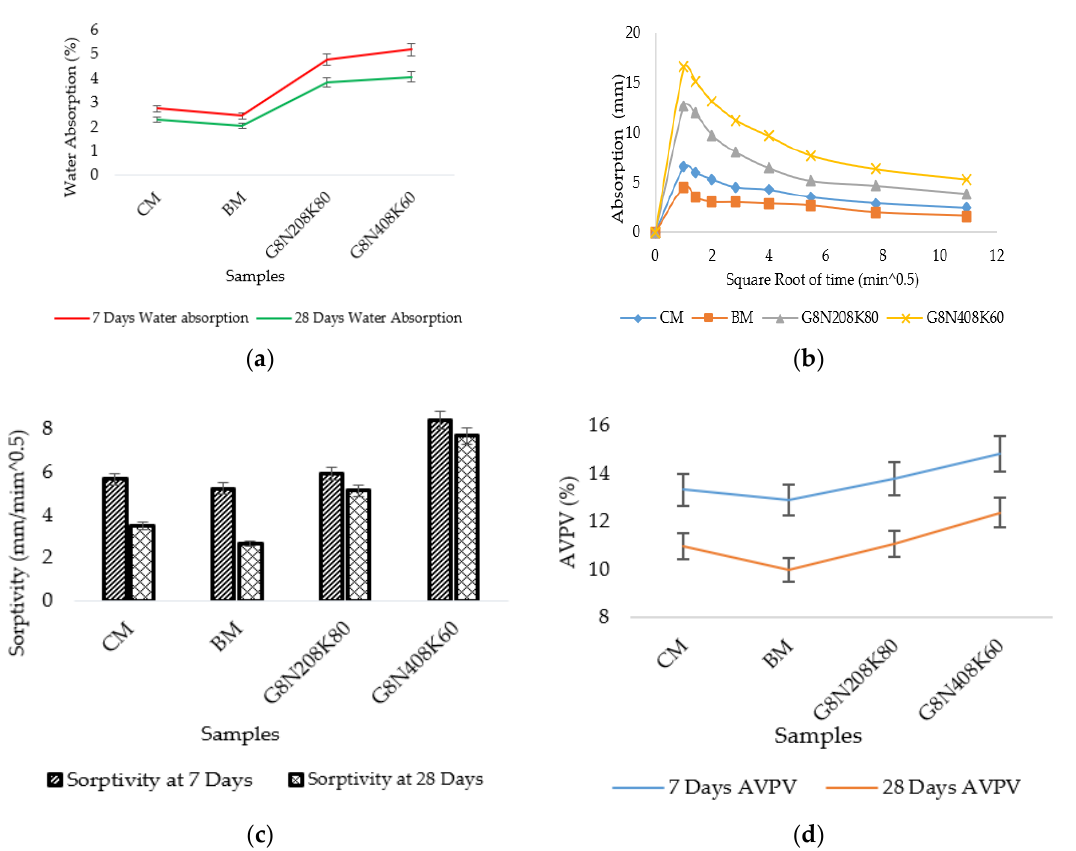
Figure 11. ( a ) Water absorption, ( b ) absorption rate, ( c ) sorptivity, and ( d ) AVPV of geopolymer concrete compression test. compression